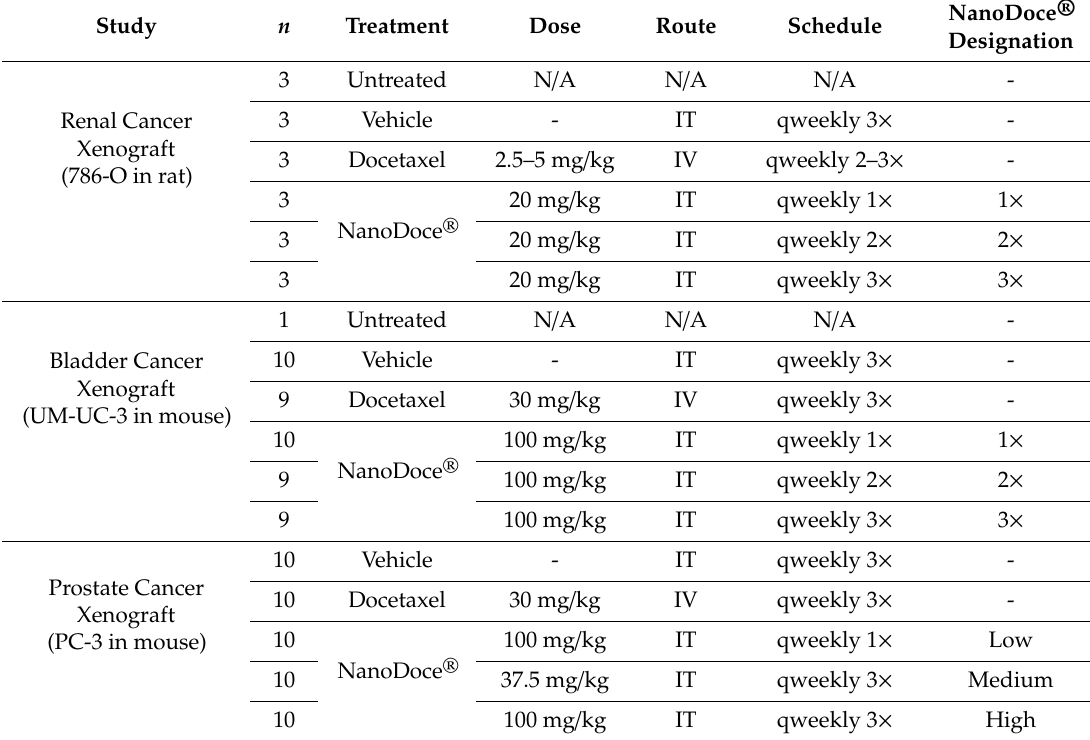
Table 1. Genitourinary-oncologic Xenograft Study Treatment